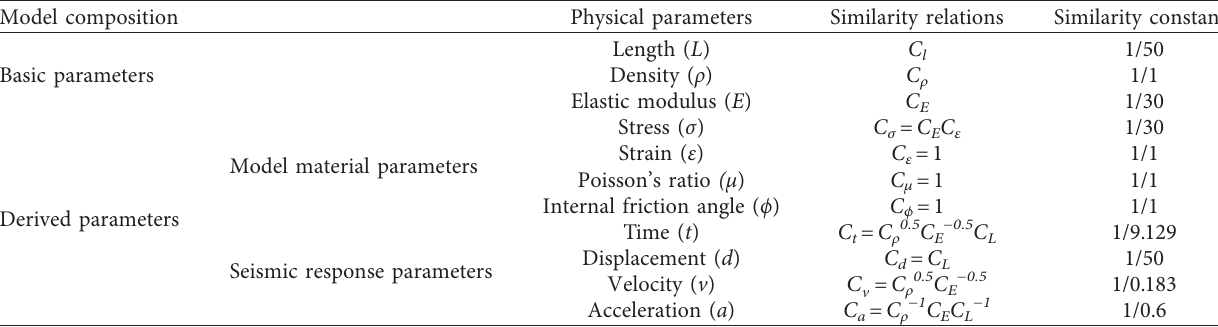
Figure 1: The spatial location of the overlapped tunnel. Table 1: Similarity relations and similarity